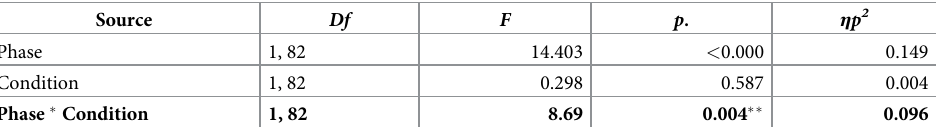
Table 6. Tabulated values for mixed ANOVA with phase (pre- versus post- manipulation preference for muscu- larity scores) as the repeated measures variable and condition (condition 5 versus condition 6) as the between-par- ticipants factor. Critical tests of our hypotheses are shown in bold.